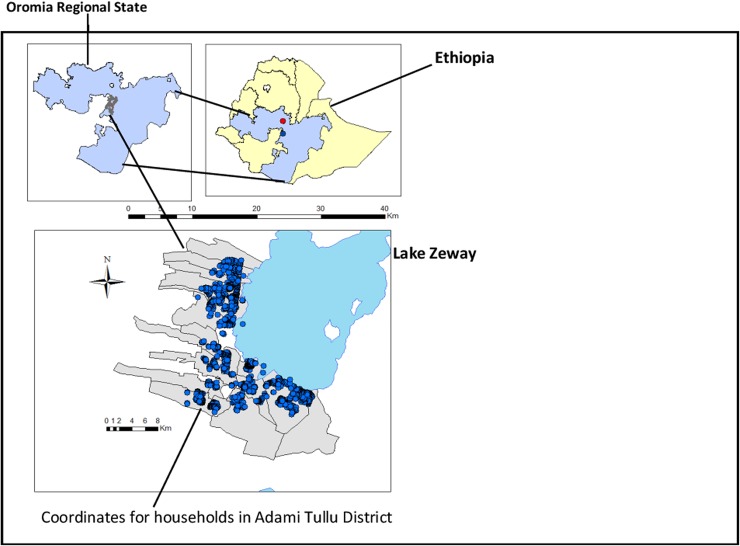
Map of Adami Tullu district in Oromia Regional State in south-central Ethiopia.Re-print under a CC BY license, with permission from Deressa et al Trials (2016).